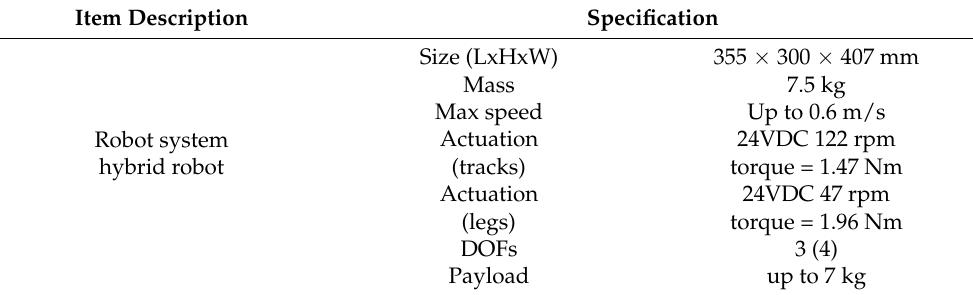
Table 1. Hybrid rover specifications.